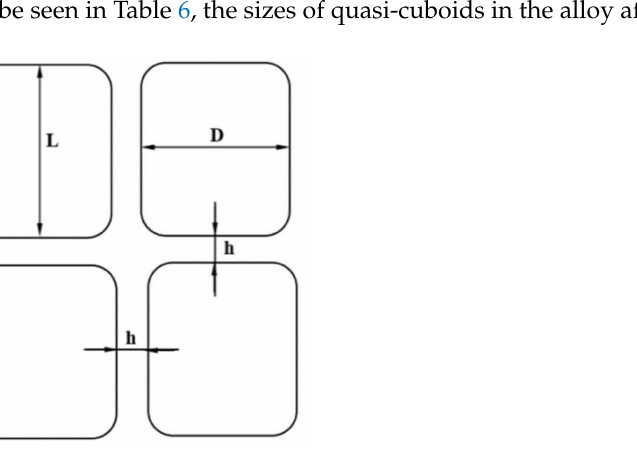
Figure 8. Schematic representation of quasi-cuboids: D—transverse; L—longitudinal size of γ (cid:48) -phase quasi-cuboids; h is the width of the γ -phase interlayers. Table 6. Quantitative properties of quasi-cuboids of the γ / γ (cid:48)